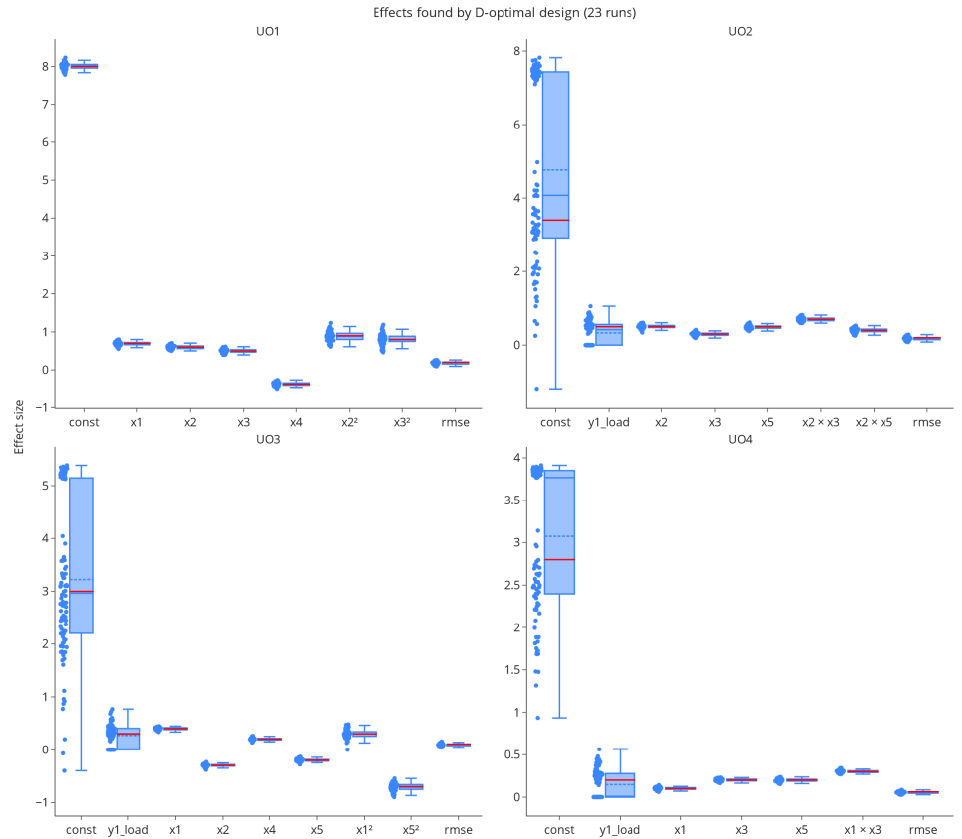
Figure 9. Parameter estimates for the full D-optimal design with 23 runs per UO. Variance in estimates is smaller than in hDoE. However, intercept and load effects are biased due to missing load data.